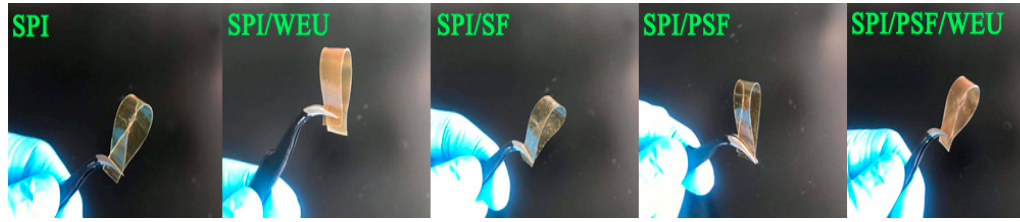
Figure 3. The digital imagines of SPI, SPI/WEU, SPI/SF, SPI/PSF, and SPI/PSF/WEU films.